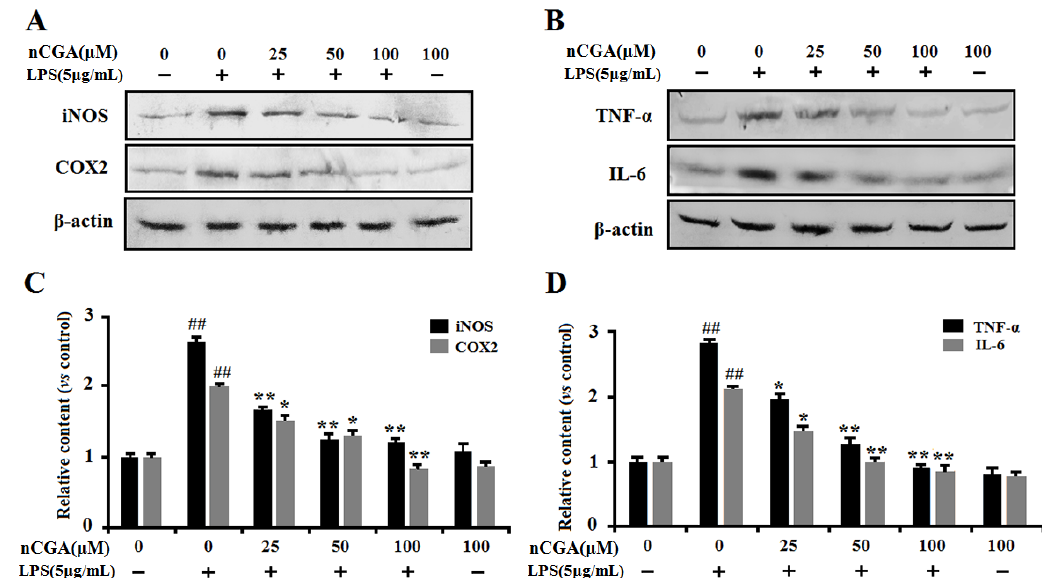
Figure 3. Effects of nCGA on the expression of inflammatory-related proteins in LPS-stimulated A549 cells. Cells were pretreated with or without various concentrations of nCGA (0, 25, 50, 100 μ M) for 2 h before LPS (5 μ g/mL) stimulation for another 24 h. ( A , B ) To further demonstrate its anti-inflammatory effects, the proteins of iNOS, COX2, TNF- α , and IL-6 expression were determined by Western blot analysis. ( C , D ) The quantitative analysis was performed by normalization with β -actin. The values represent the mean ± SD of three independent experiments, significant differences between different groups. # p < 0.05, ## p < 0.01 vs. control group, * p < 0.05, ** p < 0.01 vs. LPS alone.